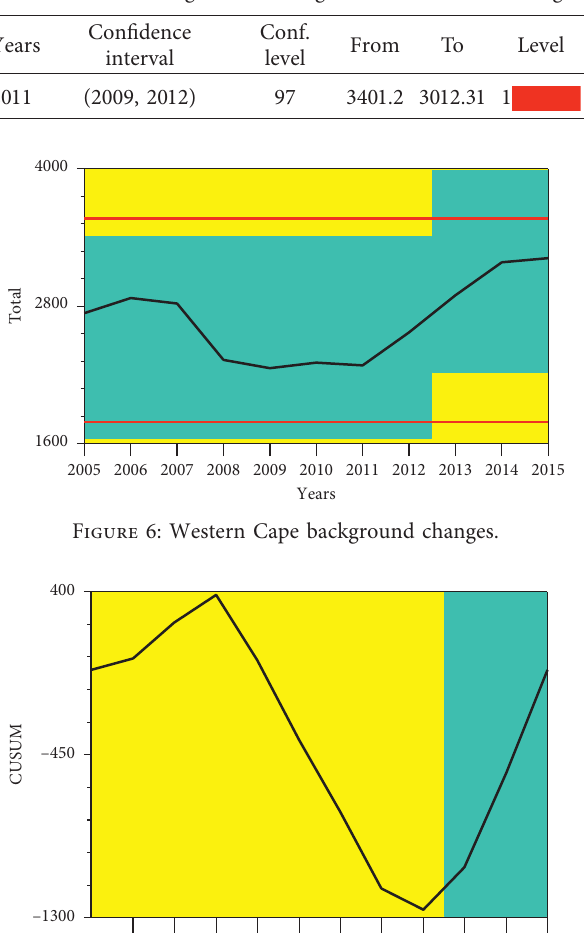
Figure 4: Gauteng: background changes.